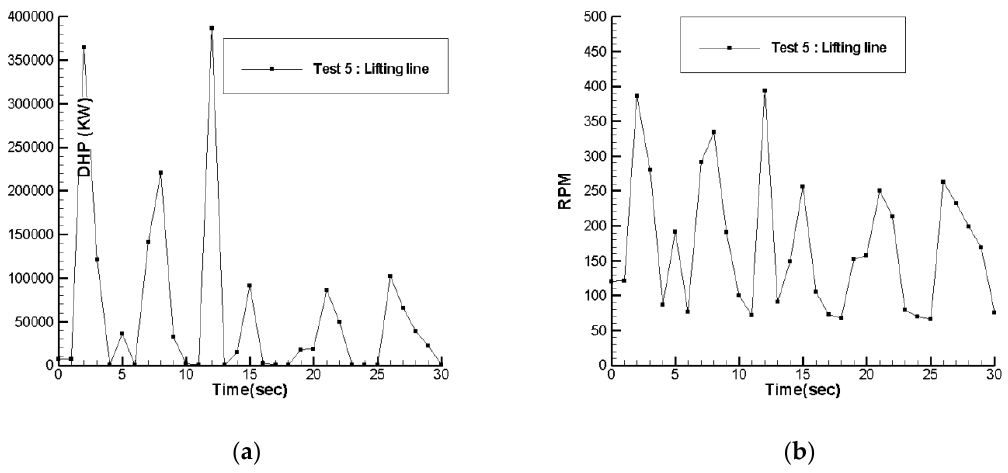
Figure 32. Time history of the required DHP ( a ) and RPM ( b ), numerical experiment #5.